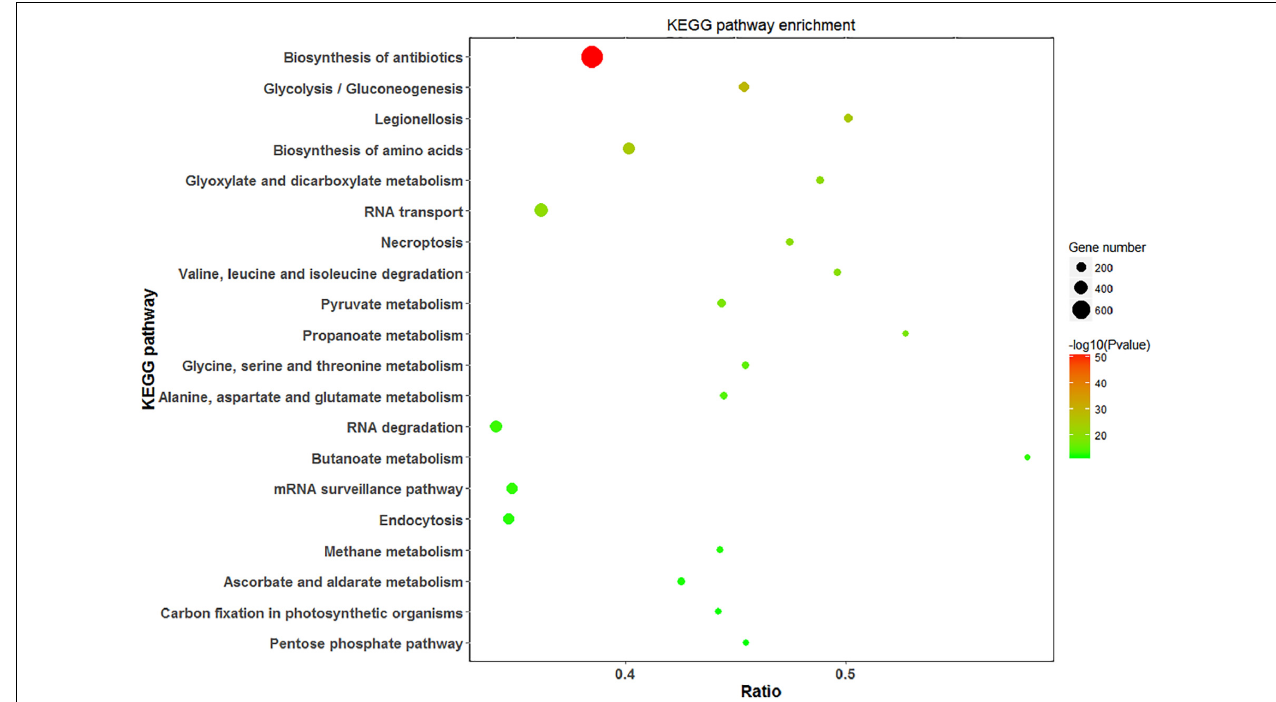
FIGURE 8 | Scatter diagram of KEGG pathway enrichment for DEPs. The top 20 pathways were listed in the plots. The X-axis corresponds to the ratio of DEPs in this pathway to all the genes in this pathway, and the Y-axis represents a different pathway. The magnitude of the dots displays gene numbers, and the q-value is described by the color